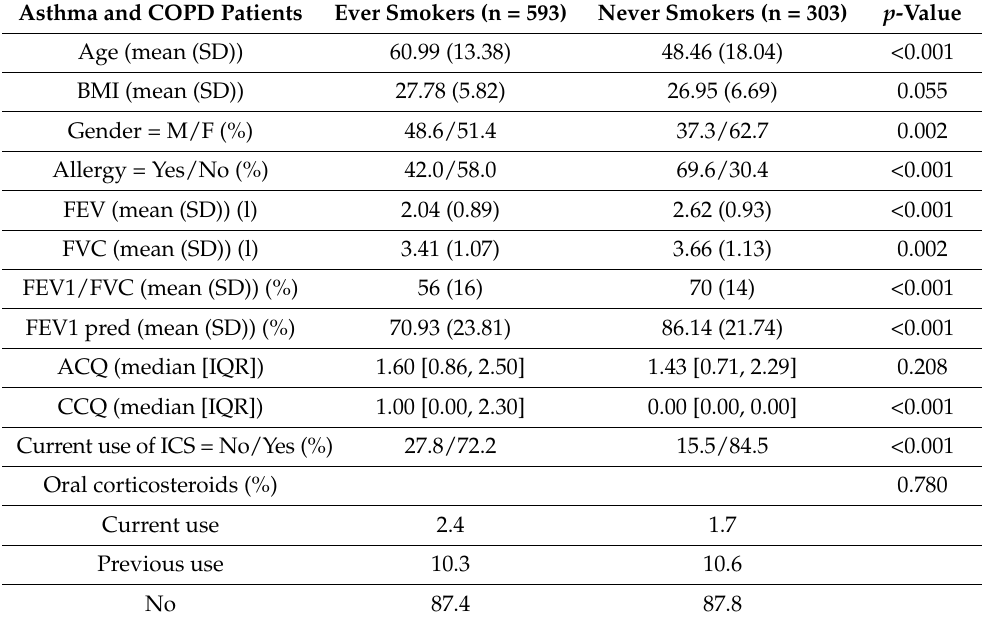
Figure 1. Flowchart of the study design of the asthma and COPD group ( a ), and healthy controls ( b ). Table 1. Demographics of asthma and chronic obstructive pulmonary disease (COPD) patients stratified by smoking status. Data are expressed in number of patients, mean ± standard deviation or median and range for non-normal